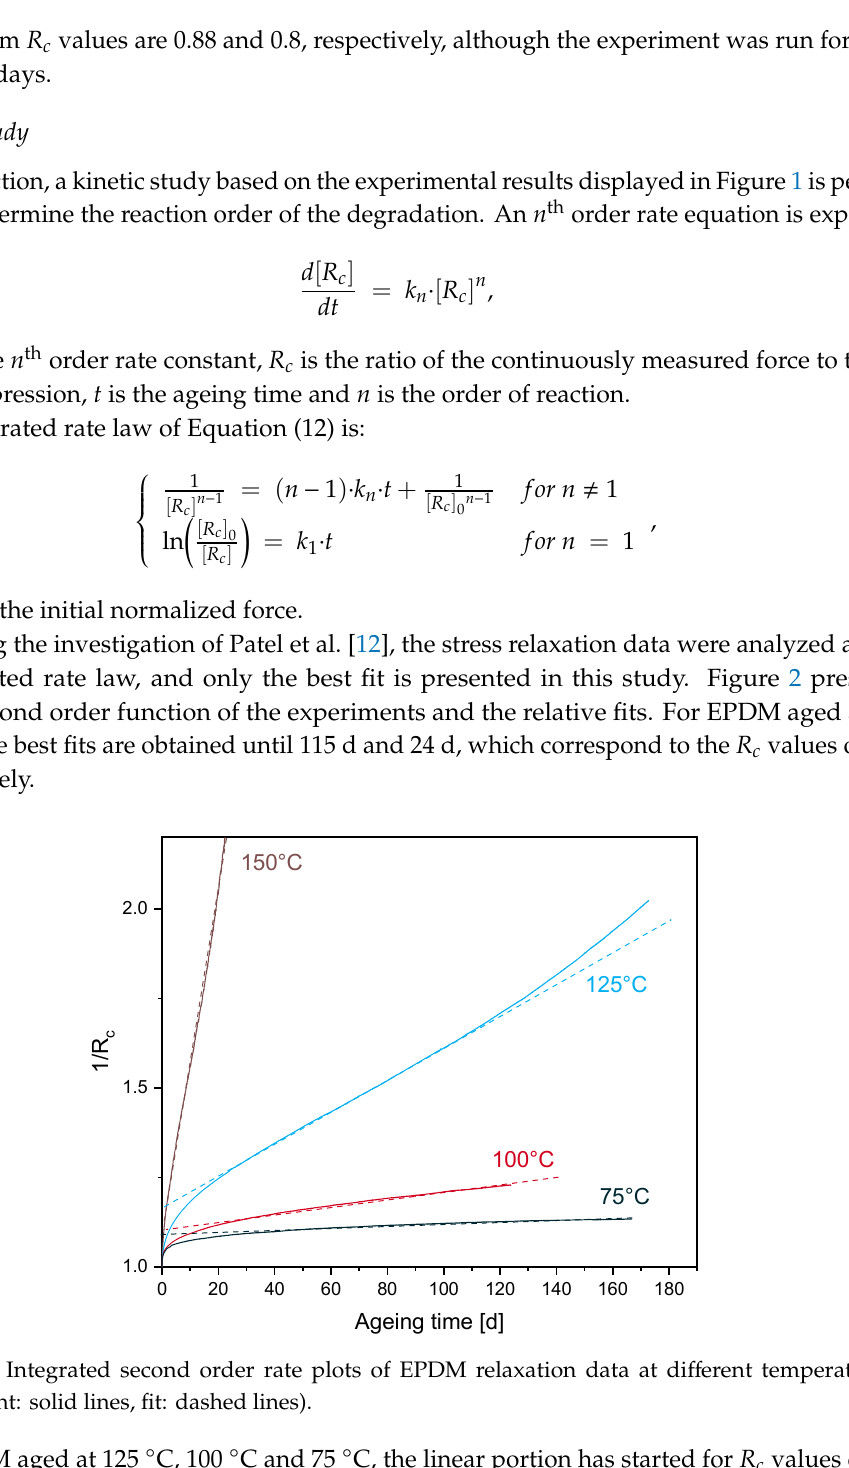
Figure 3. Correlation of the second-order kinetic rate constants (cid:1863) (cid:2870) to the Arrhenius relationship. (linear regression fit for 150 °C + 125 °C and 100 °C + 75 °C, respectively: blue dashed lines).